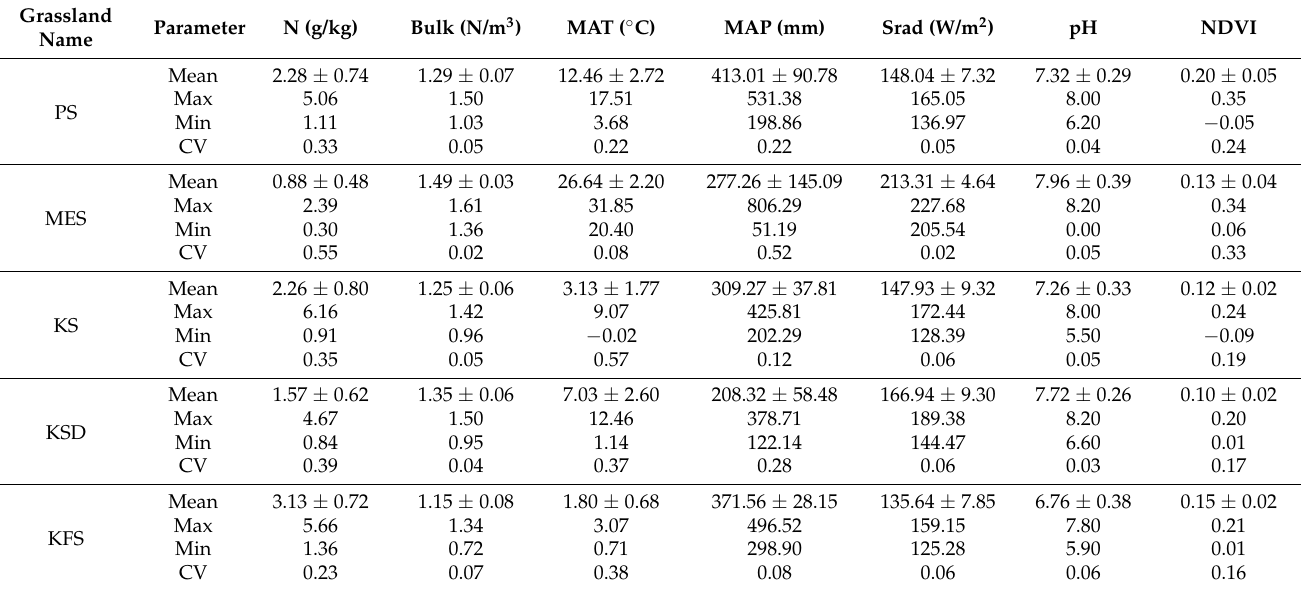
Table 1. Descriptive statistics on the nitrogen concentration and environmental variables in five representative Middle Eastern grasslands.